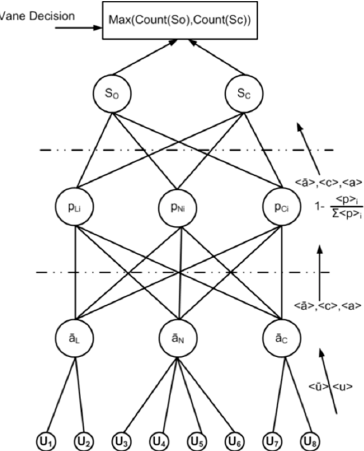
Figure 5. FITRA NN algorithm state for the calculation of vane’s operation.